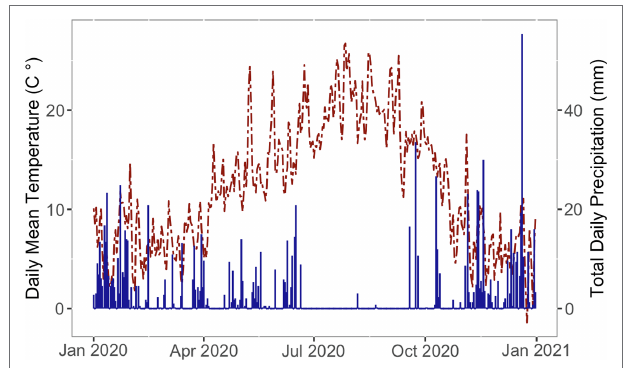
FIGURE 1 | Daily mean temperature (left axis, red dashed line) and total daily precipitation (right axis, blue solid line) at the planting location over the first growing season after planting.